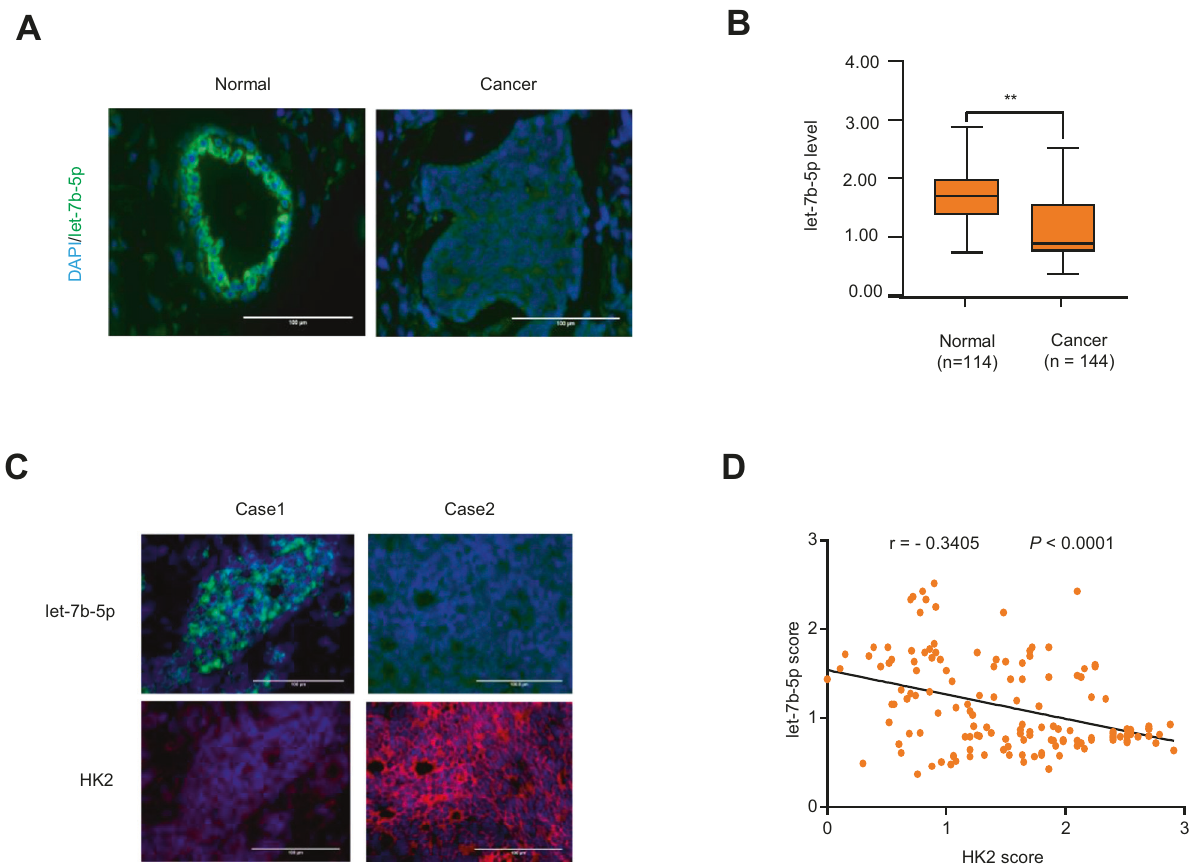
Fig. 7 Correlation analysis between let-7b-5p and HK2 in patients with breast cancer. A Immuno fl uorescence staining of let-7b-5p in 114 normal samples and 144 BC samples. Scale bar, 100 μ m. B Let-7b-5p expression was analyzed between 114 normal and 144 BC tissues by Mann – Whitney U test. C Representative immuno fl uorescence imaging o of 144 BC patients. HK2 expression were detected by IHC, and let-7b- 5p expression were detected by miRNA FISH. Scale bar, 100 μ m. D Correlation analysis of let-7b-5p and HK2 expression in 144 BC